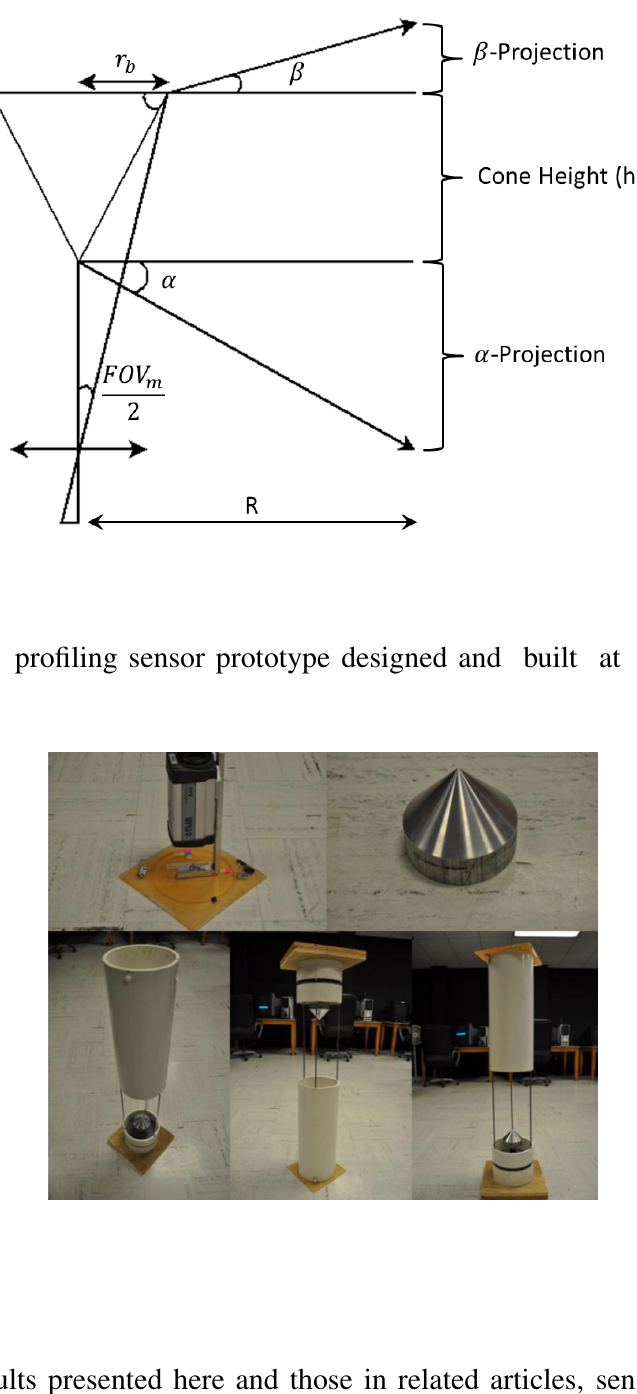
Figure 18. Layout of a 360 ◦ profiling sensor [28].